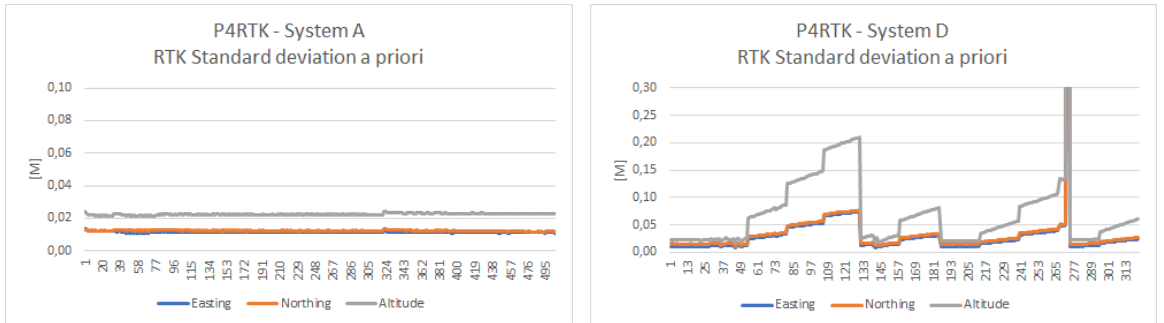
Figure 3. Standard deviations (a priori) of RTK-based image positions (measured EO) of Phantom 4 RTK systems A and D. Note: the vertical scaling of system D differs from that of systems A